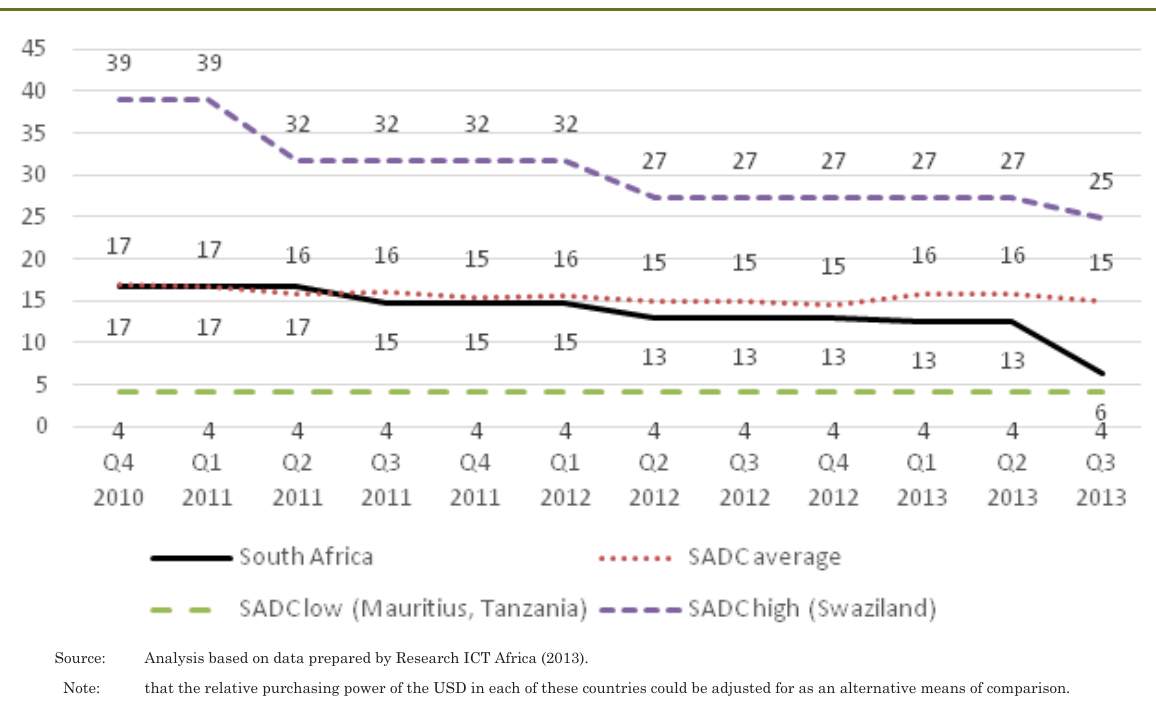
FIGURE 2: LOWEST AVAILABLE SADC PREPAID PRICES (USD), OECD USAGE BASKET (2010-2013)